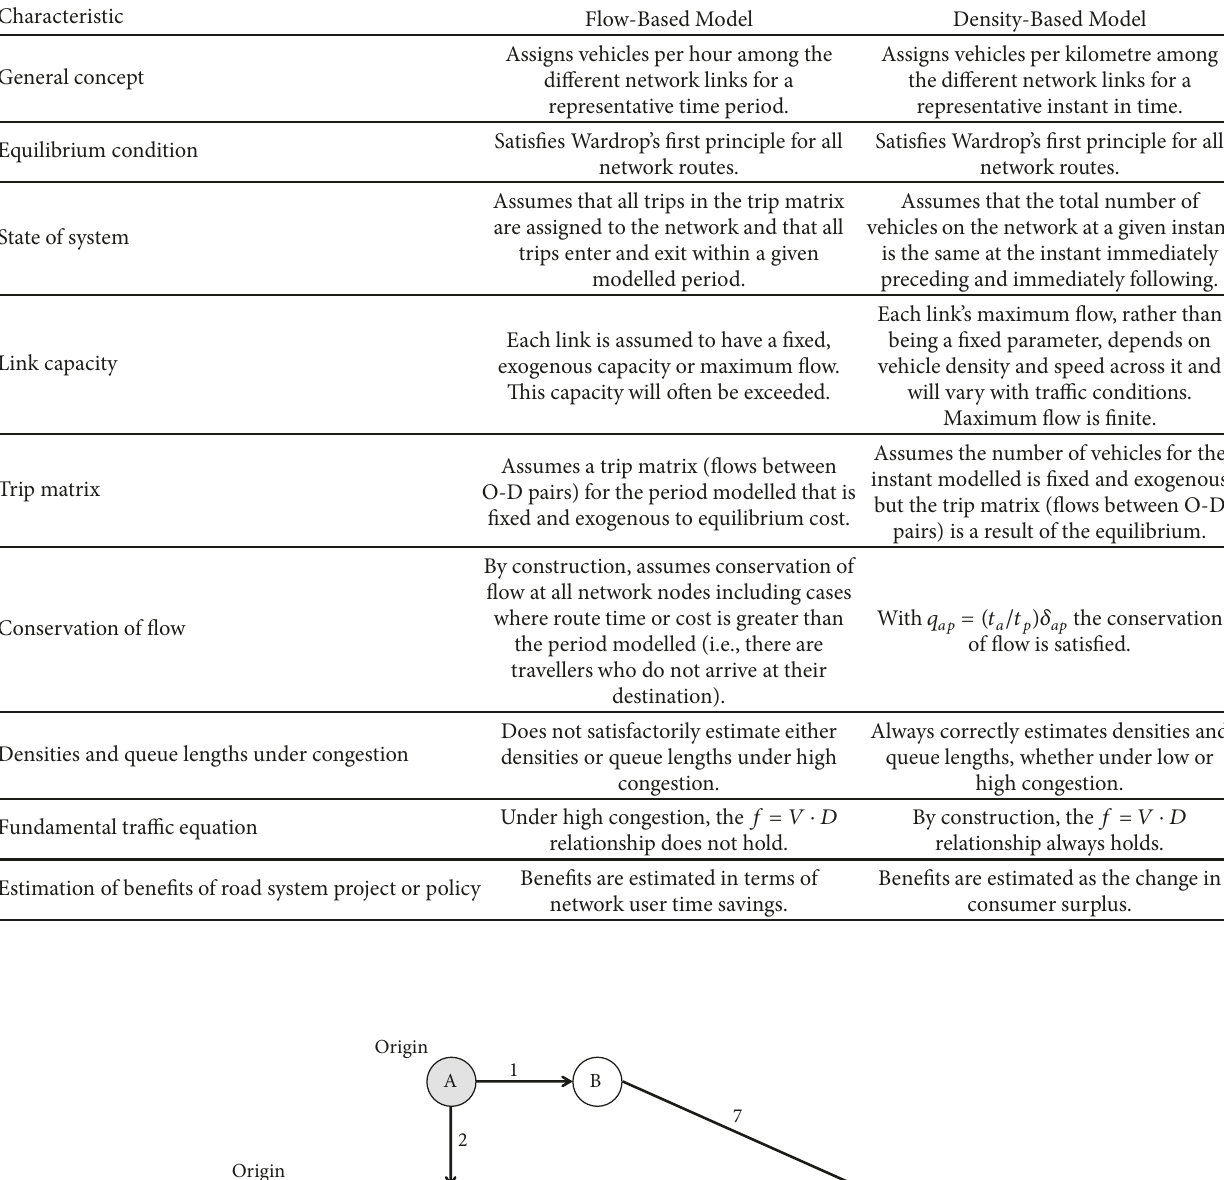
Table 1: Summary of Main Differences between Flow-Based and Density-Based Models.